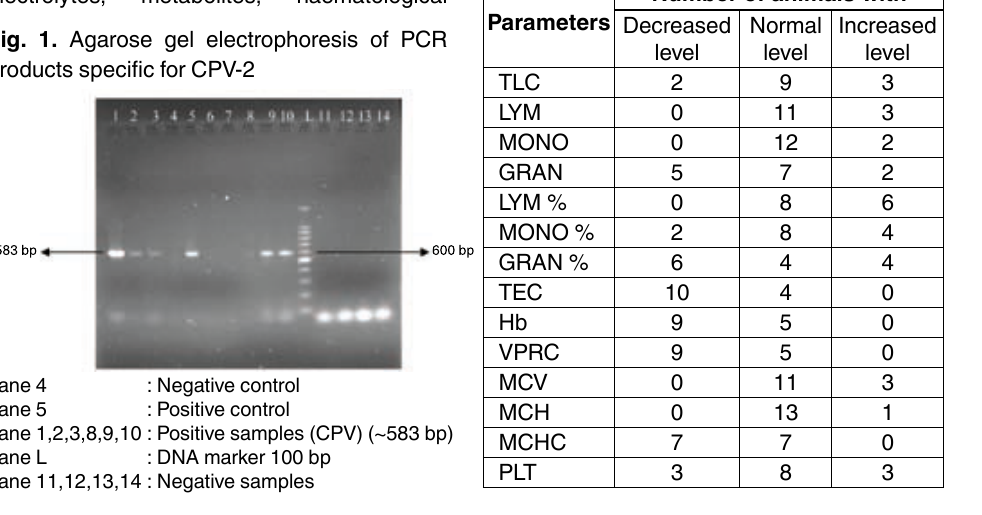
table 5. Number CPV infected dogs with various alterations in different